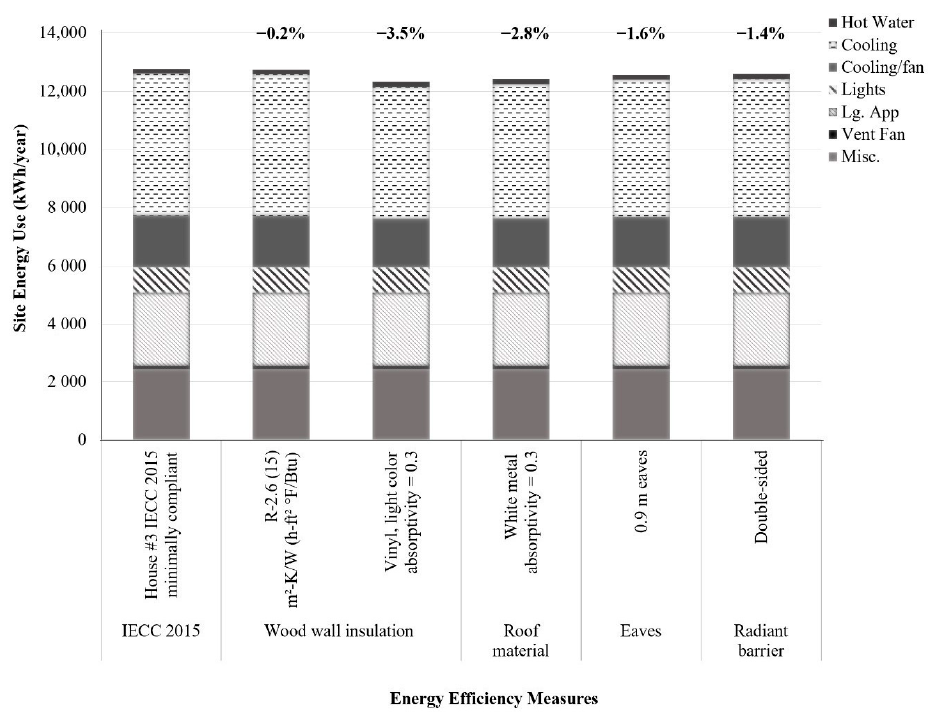
Figure 2. Simulated annual site energy (kWh / year) consumption for selected parametric building Figure2 envelope energy e ffi ciency measures vs. the IECC 2015 baseline. Percent changes in annual energy use are